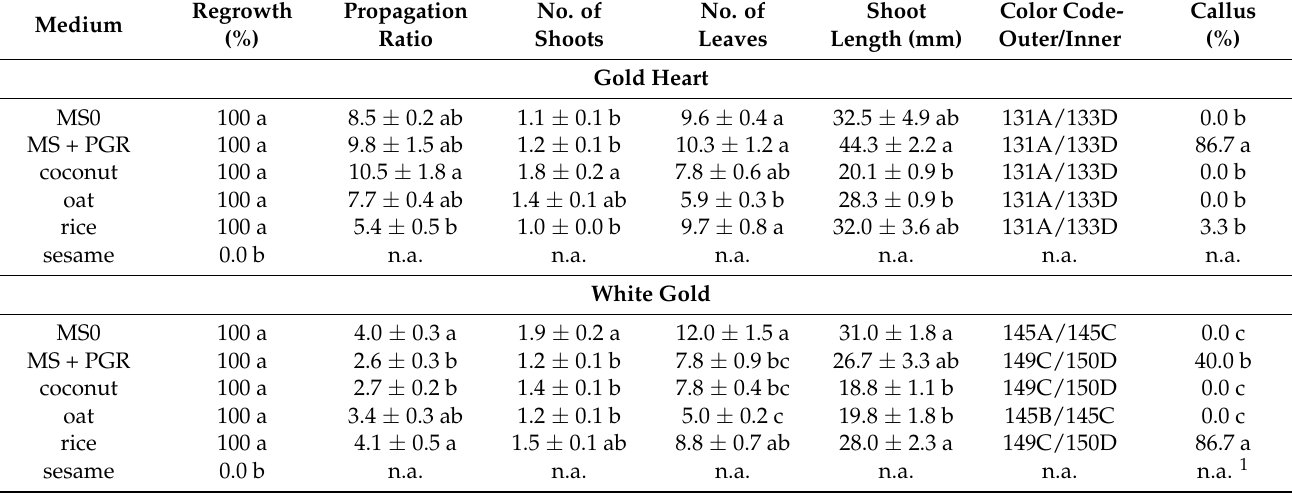
Table 1. Influence of medium composition on the explant regrowth level (%), propagation ratio, number, and length (mm) of shoots produced by a single explant, number and colour (RHSCC) of leaves, as well as the share (%) of explants forming callus after 10 weeks of culture.